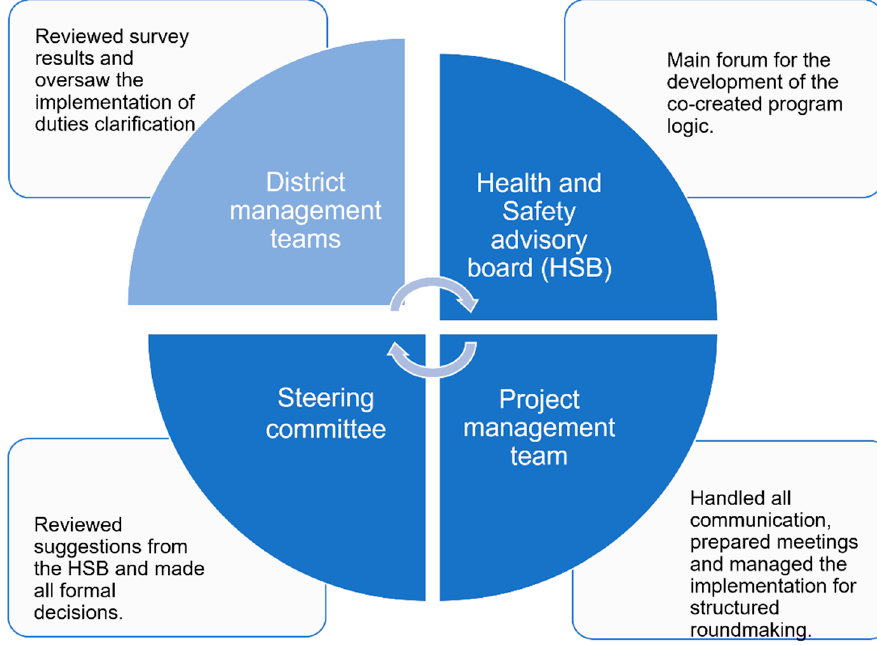
Figure 1. Groups involved in the co-creation process and their different roles. Table 1. Number of activities included in the co-creation process and when in time they occurred.